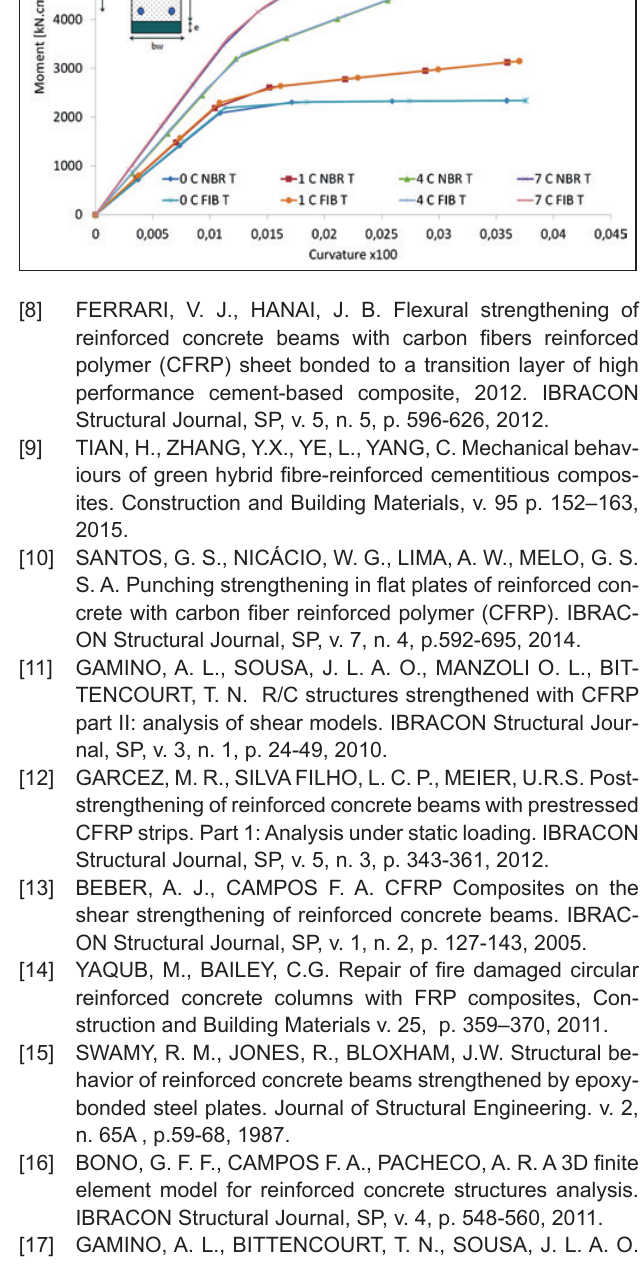
Figure 10 – Function moment - curvature for beams with “T” cross section taking in comparison NBR-6118 and fib codes. About nomenclature, 7 C FIB T means that has 7 strengthening layers, fib code and “T” cross